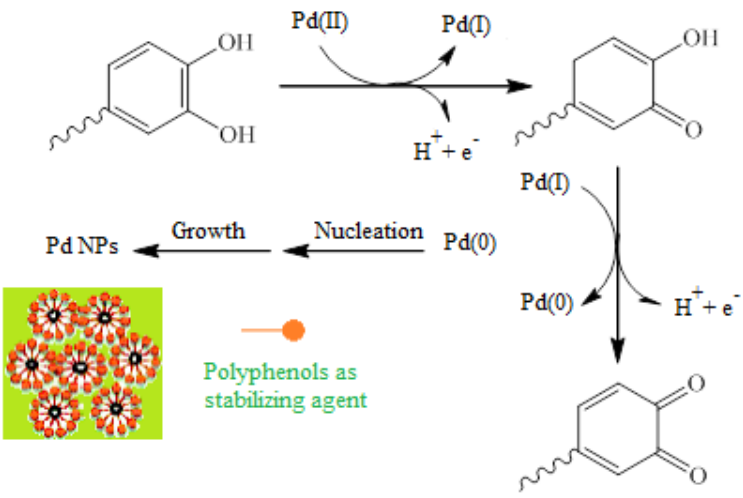
Scheme 1. The Pd NPs preparation by using the M. vulgare L leaf extract .